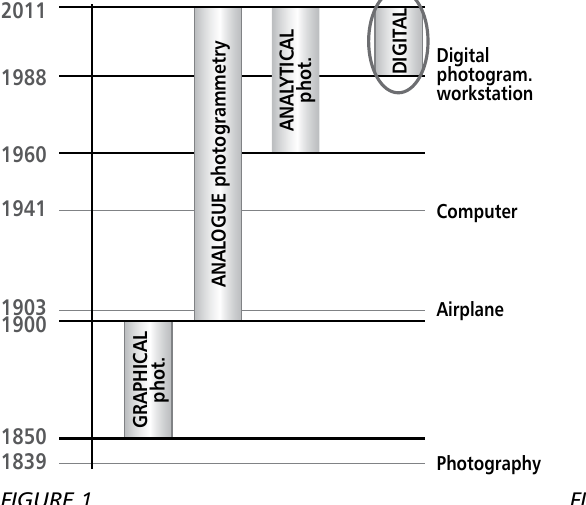
Phases of photogrammetric development, as a result of technological innovations (source [36])